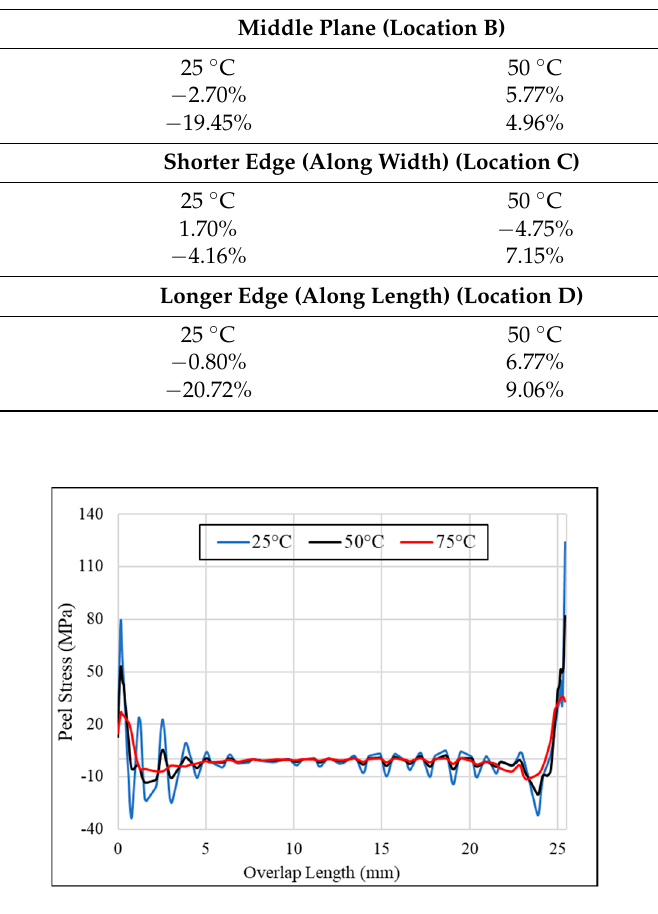
Figure 14. Peel stress distribution at location A of SLJ with Al 2 O 3 nanoparticles in the adhesive at different temperatures.